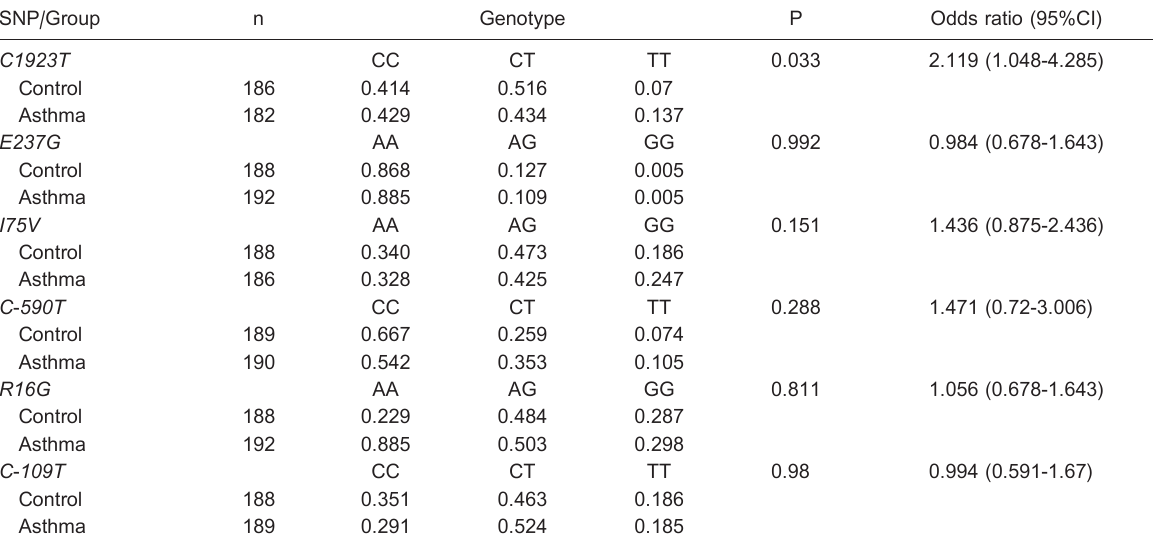
Table 1. Distribution of SNPs in the Mauritian Indian population. SNP/Group